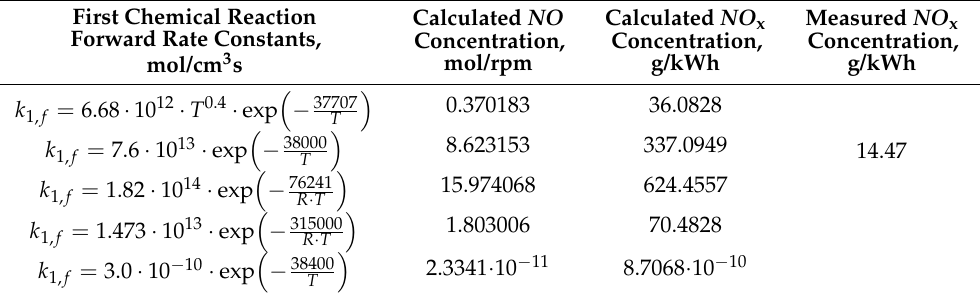
Table 4. Nitric oxide emission formation using different kinetic coefficients k 1 , f at 75% MCR [22]. First Chemical Reaction Calculated NO Forward Rate Constants, Concentration, mol/cm 3 s